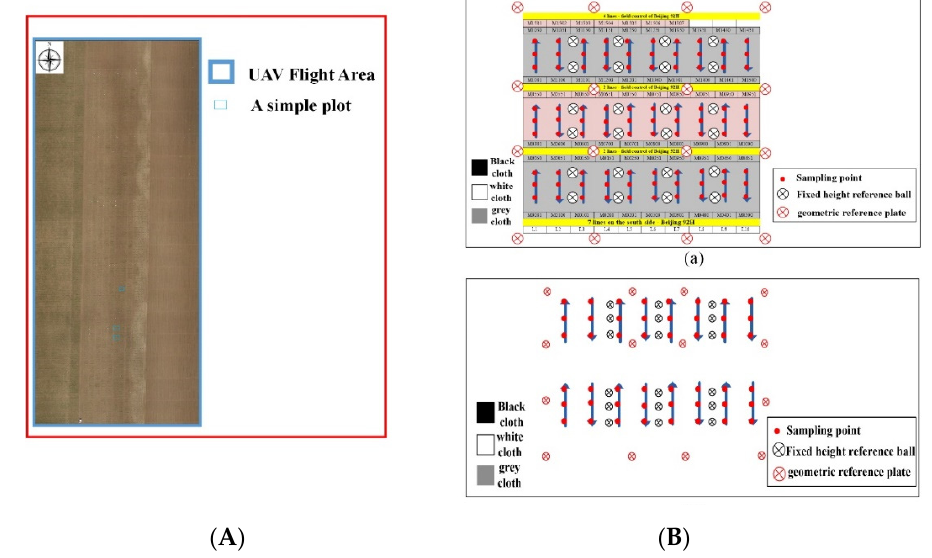
Figure 1. Description of the study area and design of the data acquisition based on an unmanned aerial vehicle (UAV) platform. ( A ) Schematic diagram of experimental area and selected plots, ( B ) Location of sampling points and ground control points.